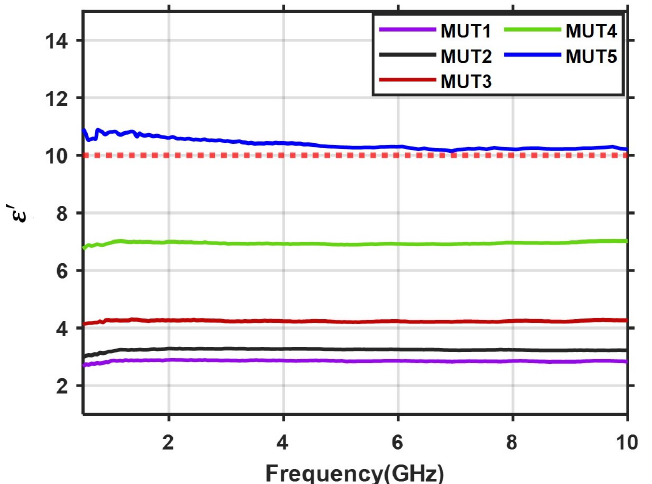
Figure 4. Measured dielectric constant values for the five MUTs using the process described in Section 2. The red dotted line represents the minimum recommended value for stroke detection, as calculated in